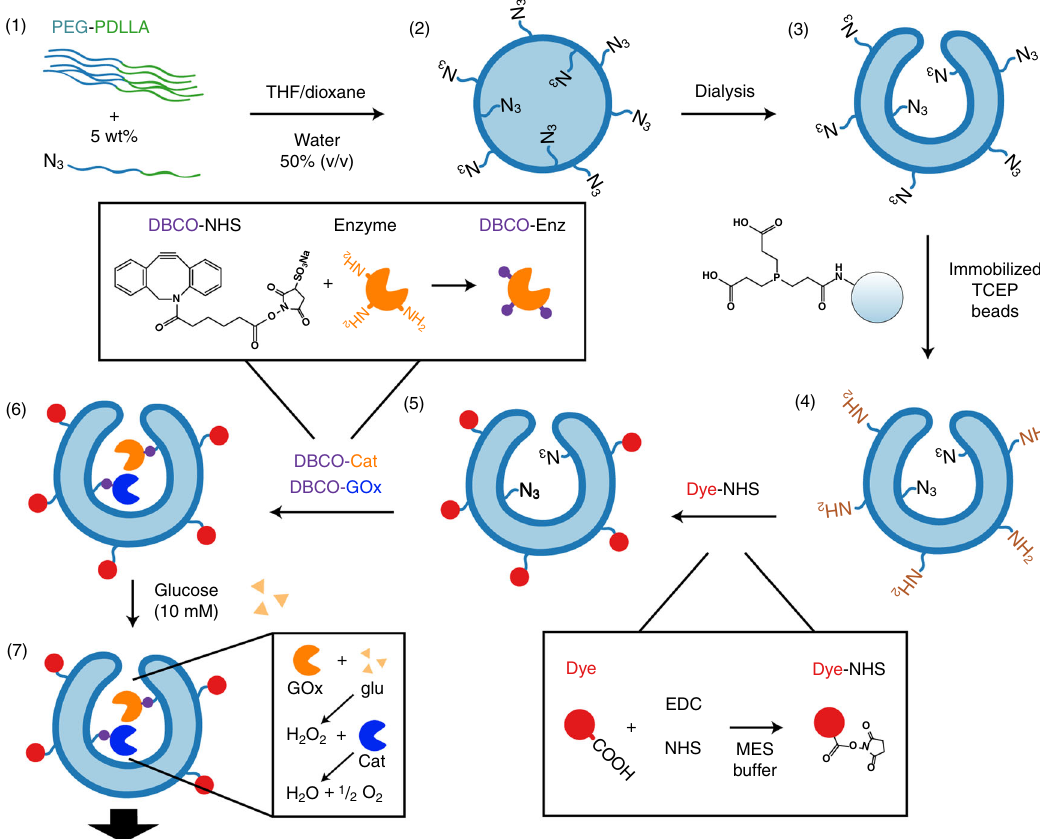
Fig. 1 Universal method to form polymeric nanomotors with spatial control over catalyst. (1) Formation of amphiphilic poly(ethylene glycol)-b-poly(D,L-lactide) (PEG-PDLLA) block copolymers, including an azide terminated block copolymer to act as functional handle. (2) Self-assembly of block copolymers with 5wt% azide polymer into spherical polymersomes. (3) Shape transformation of the polymersomes into stomatocytes. Azide handles in the inner membrane of the stomatocyte are not shown for clarity. (4) Reduction of azide groups to amine groups on the outer surface by immobilized TCEP beads that are too large to enter the cavity. (5) Attachment of a dye to the amine groups on the outside via EDC coupling. (6) Covalent coupling of enzymes into the stomatocyte cavity via SPAAC. (7) Addition of physiological amounts of glucose activates the enzyme cascade to produce water and oxygen that propel the system